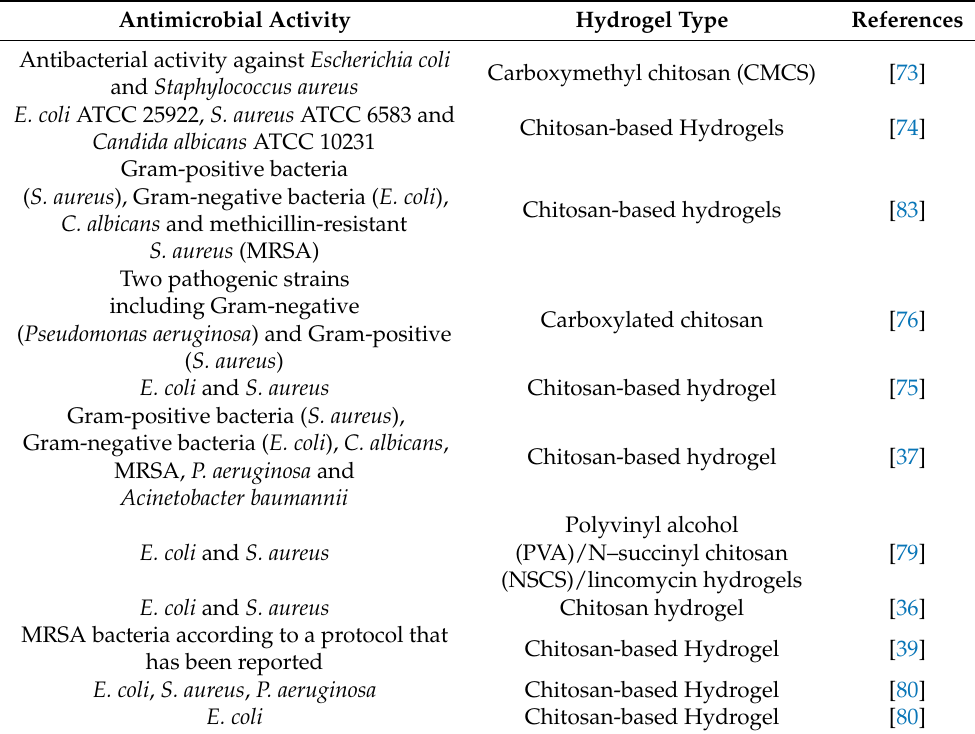
Table 1. Different types of chitosan-based hydrogels for antimicrobial